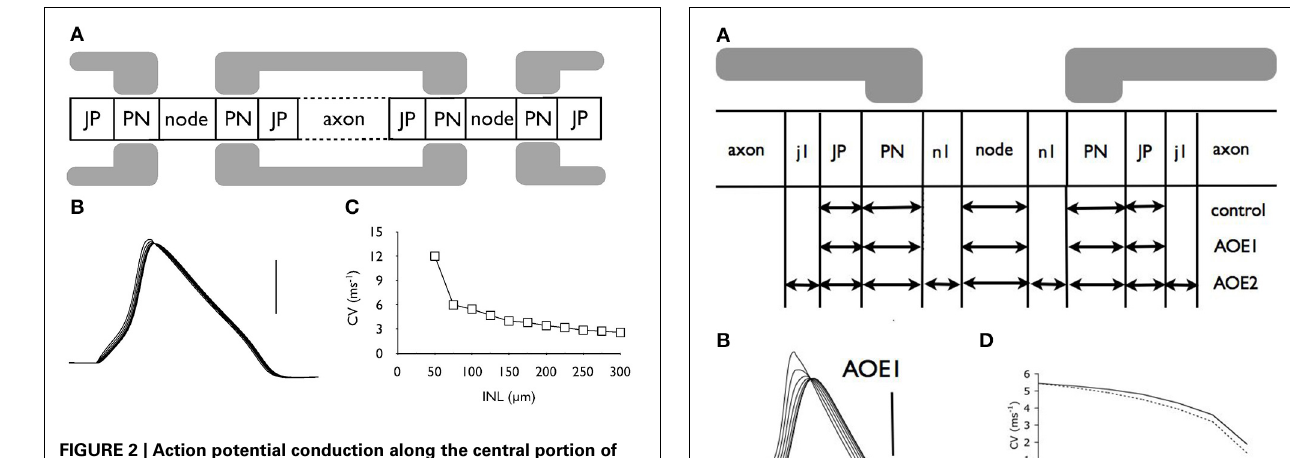
FIGURE 2 | Action potential conduction along the central portion of the auditory nerve. (A) Schematic model of the axonal compartments in the control auditory nerve model. (B) Evoked action potentials recorded at six successive nodes illustrating action potential conduction along an axon. Scale bar is 50mV and the duration of the recording is 2ms. (C) The conduction velocity decreases as internodal length (INL) is increased from the control value of 100 μ m.